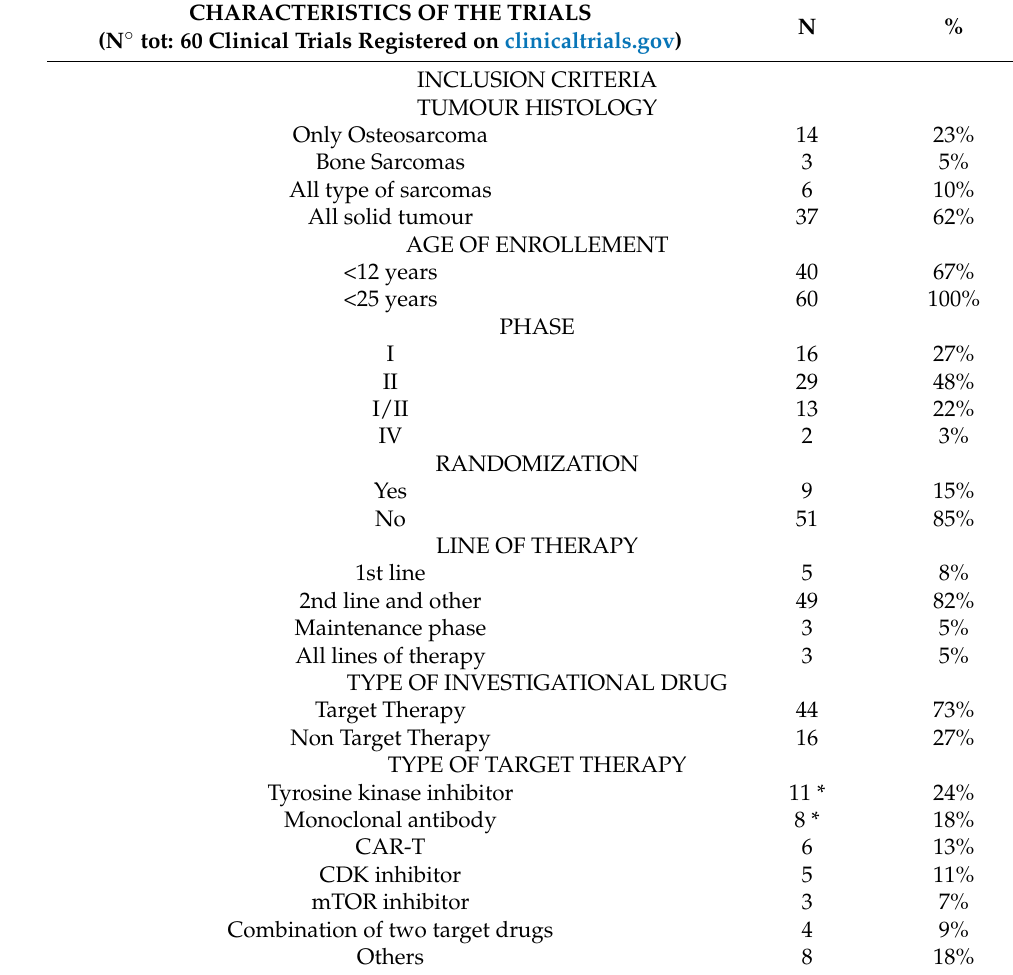
Table 3. Main characteristics of the active clinical trial recruiting patients with relapsed/refractory OS. CHARACTERISTICS OF THE